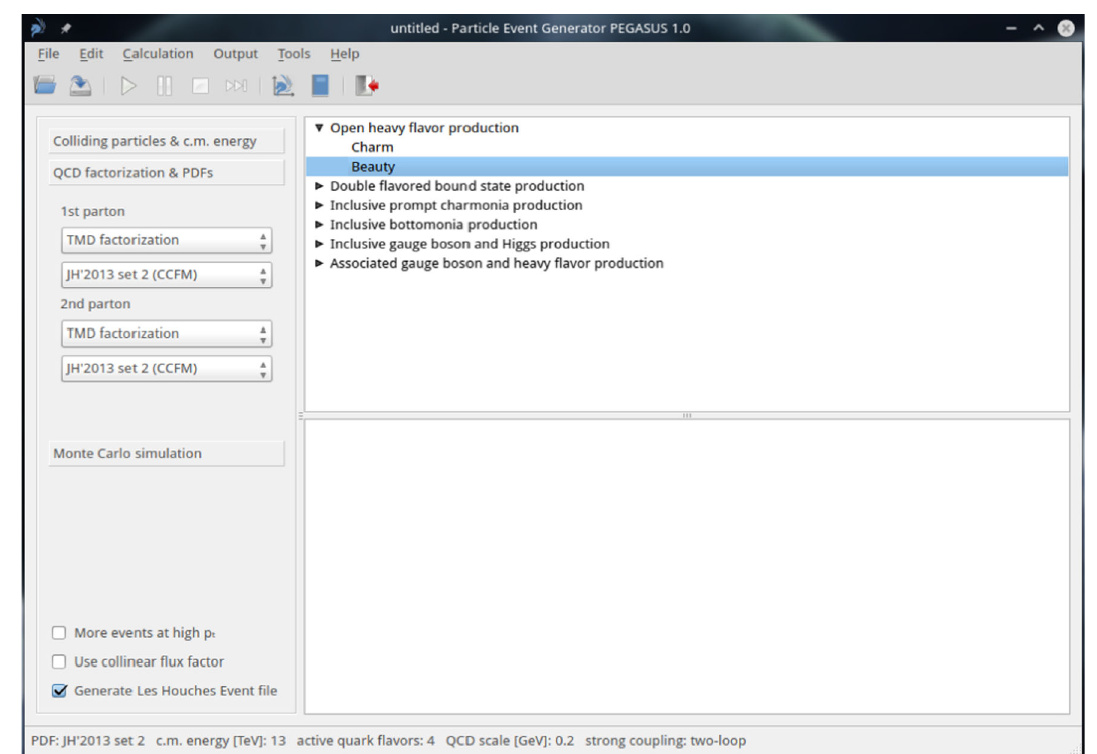
Fig. 1 pegasus main window. Here one can select factoriza- tion scheme (TMD or collinear one) for each of the collid- ing particles, choose corresponding parton density function and